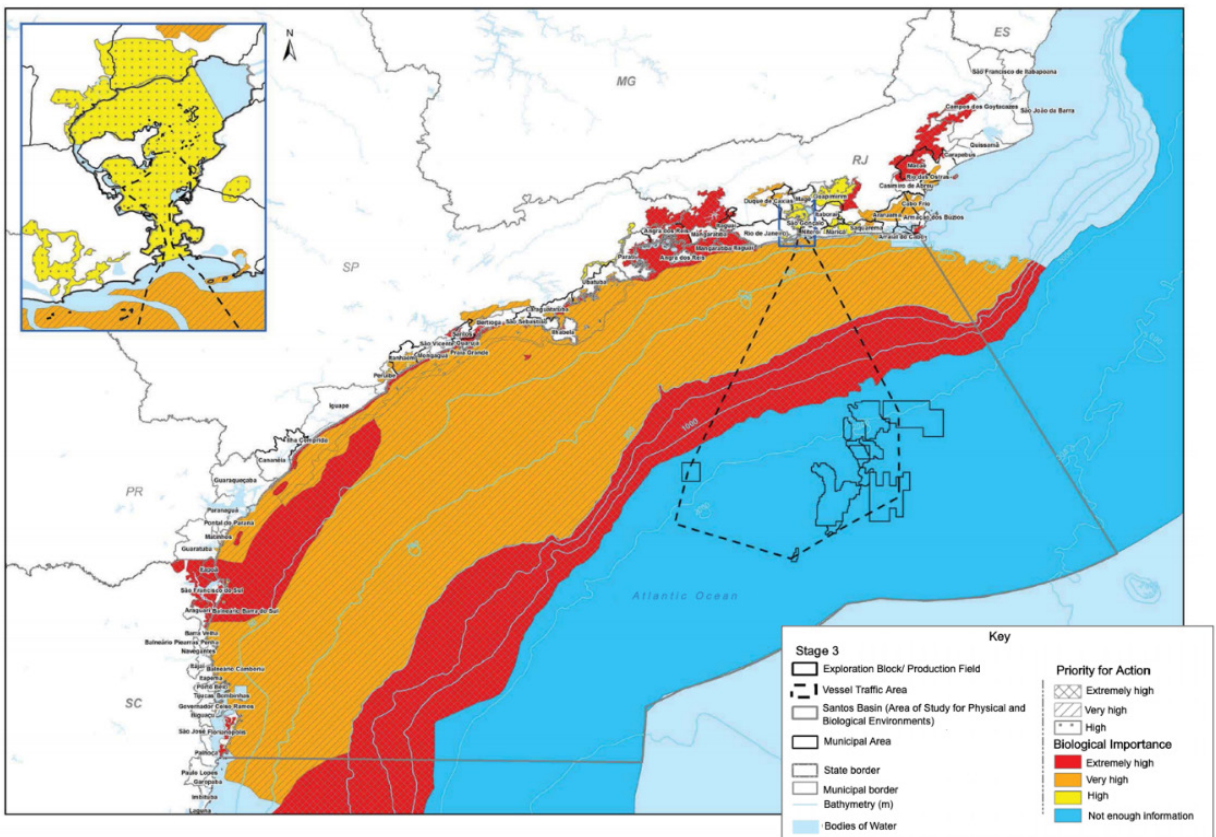
Figure 3. Priority areas for conservation of biodiversity according to the Ministry of Environment.